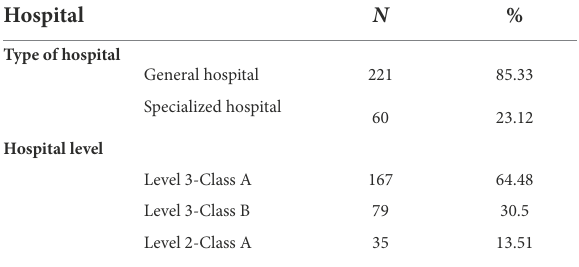
TABLE 1 The number and percentage of patients with stoma in different hospital ( N =